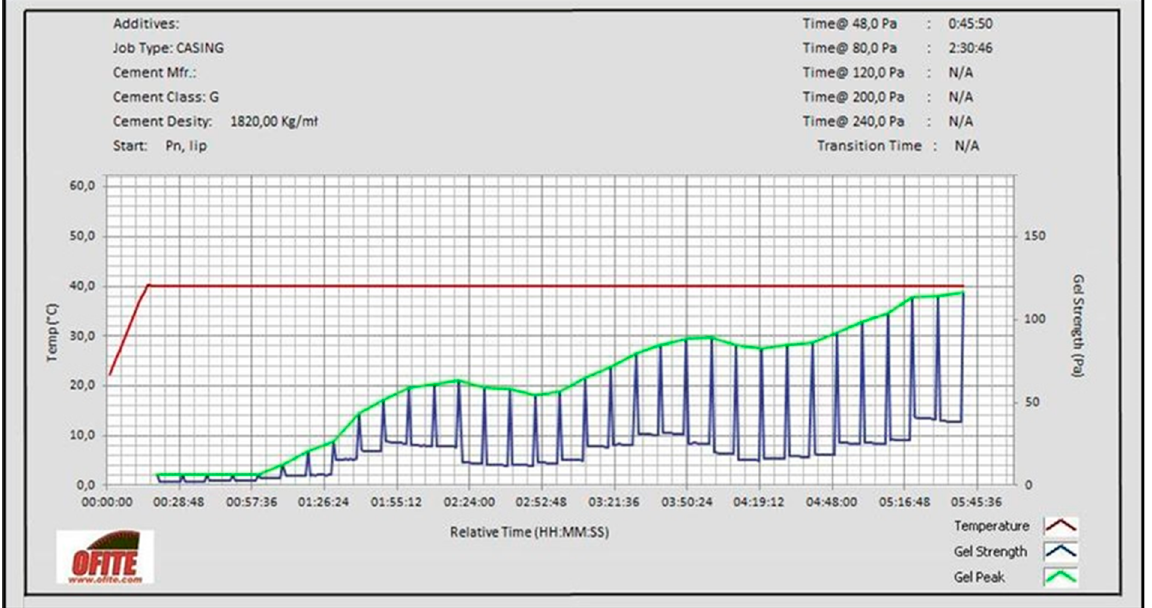
Figure 8. Static structural strength build-up for slurry with low anti-migration resistance.